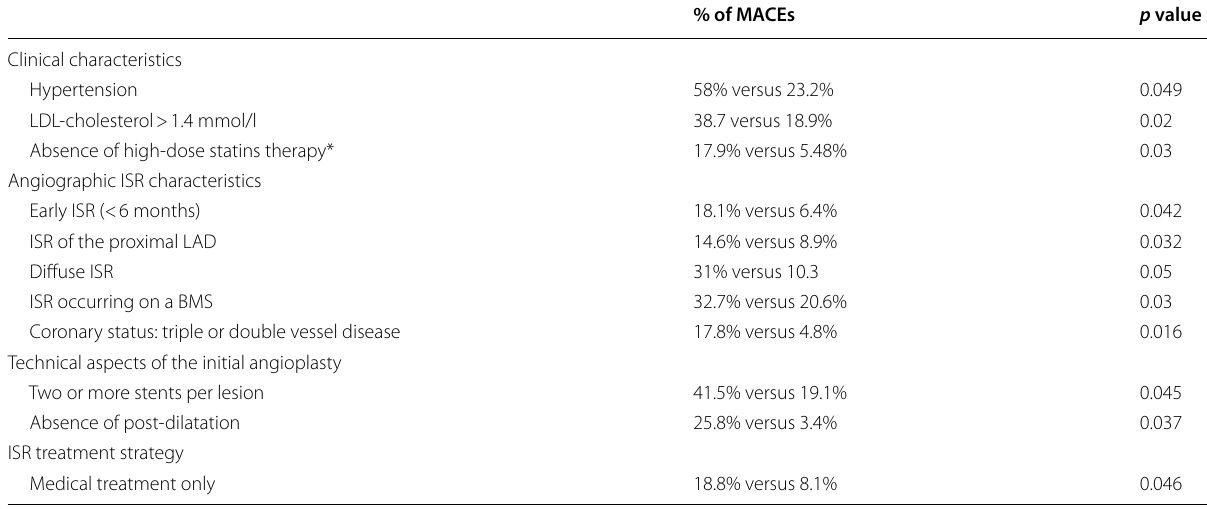
Table 4 main predictors of major adverse cardiac events during follow-up identified with univariate